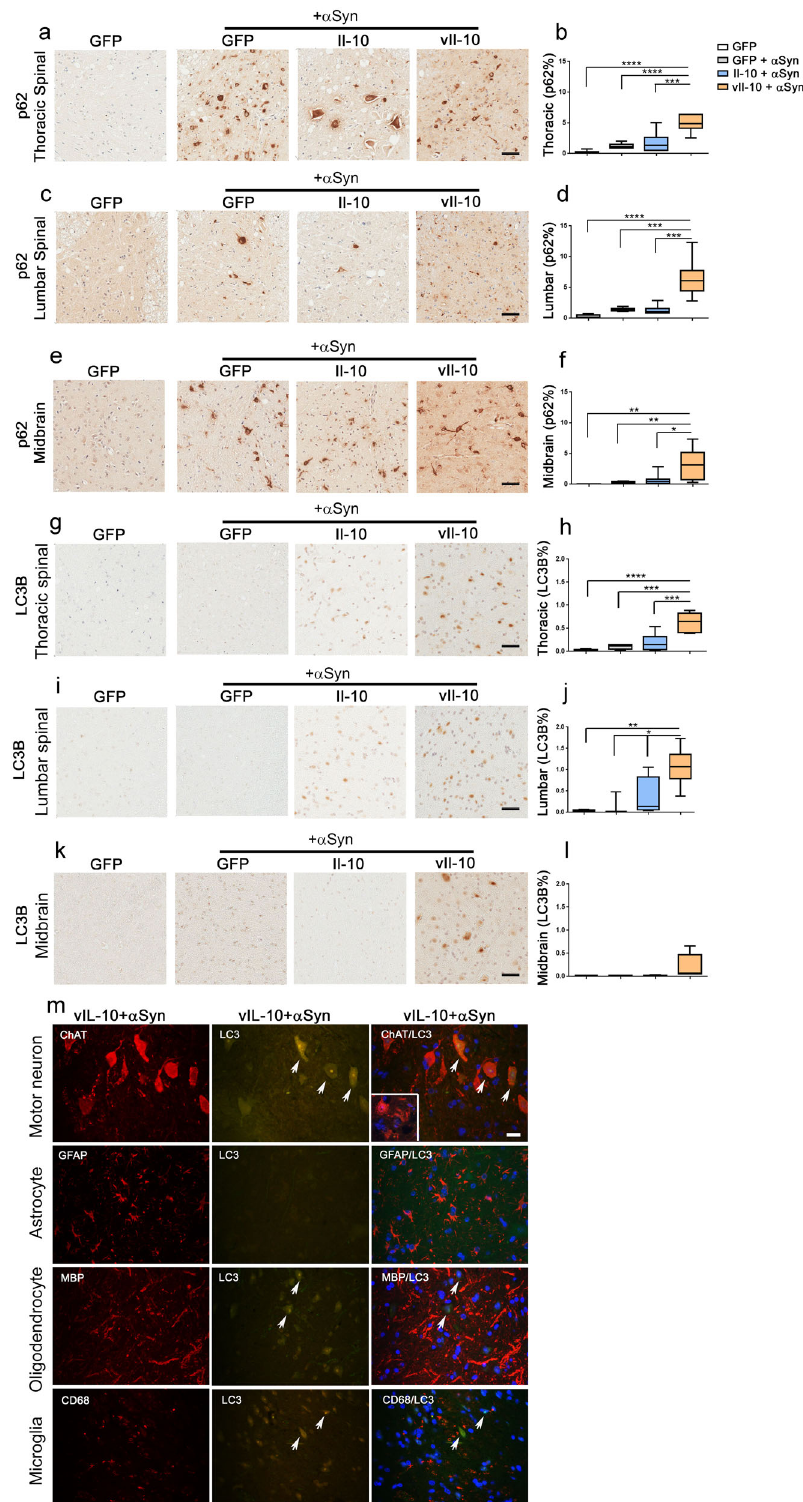
Representative images from the lumbar spinal cord of vIL-10- expressing mice seeded with α Syn fi brils showed robust LC3B staining in the ChAT-immunopositive neurons (arrows, top panel, Fig. 7m). None of the other cell types tested (astrocytes, oligodendrocytes, and microglia) show appreciable